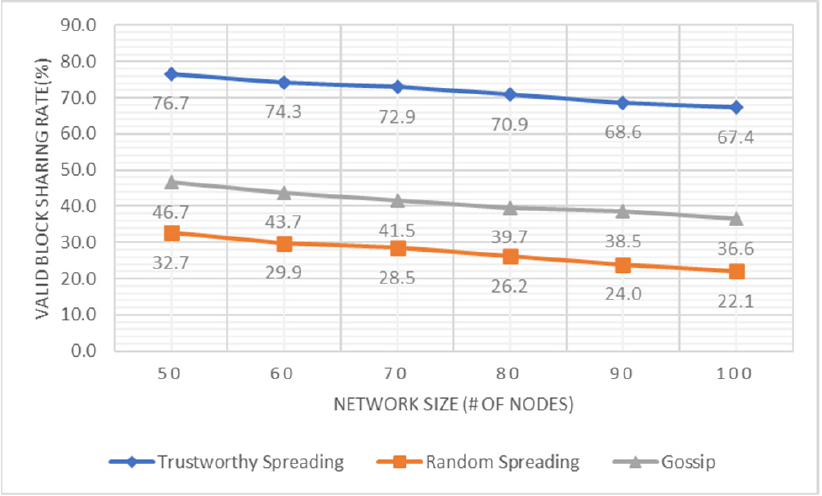
Figure 9. Valid block sharing rate. Figure 10 indicates the rate at which a transaction passes through a less reliable area.